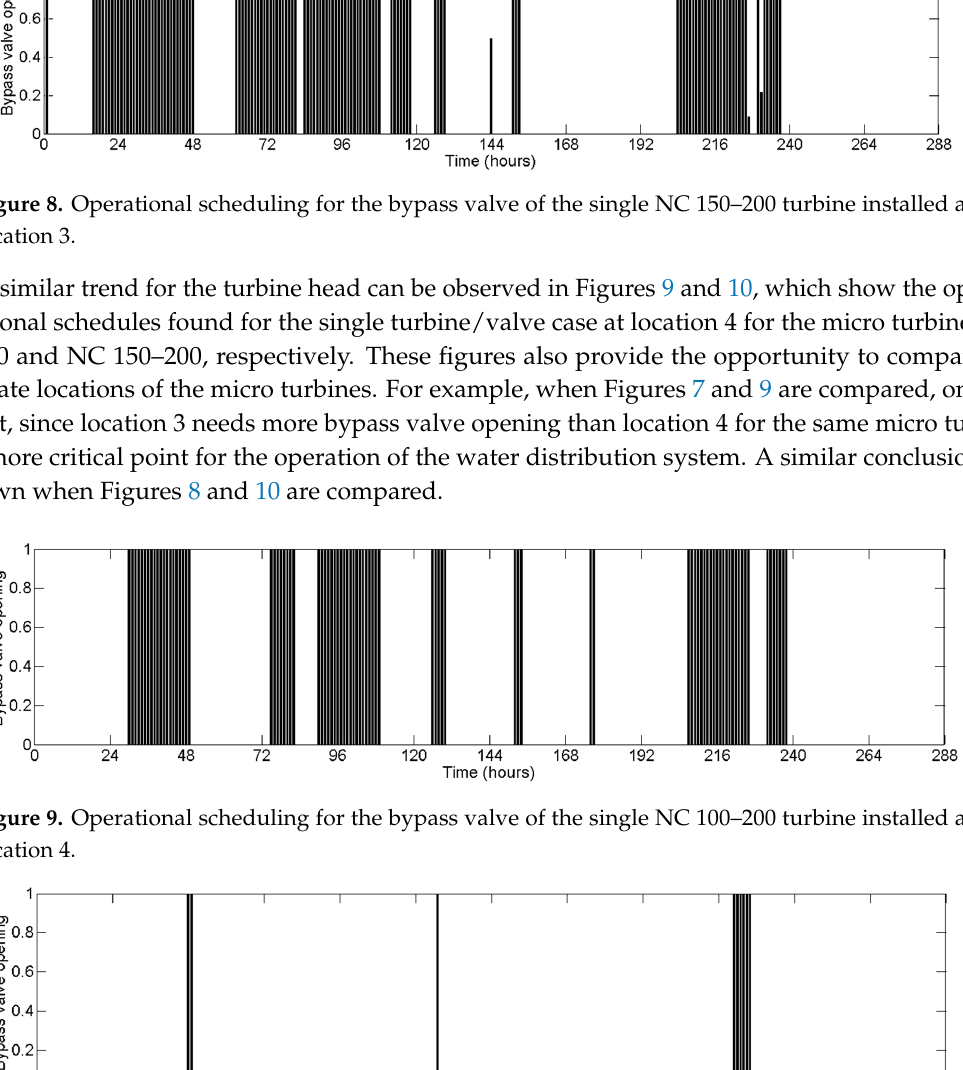
Figure 7. Operational scheduling for the bypass valve of the single NC 100–200 turbine installed at location 3.